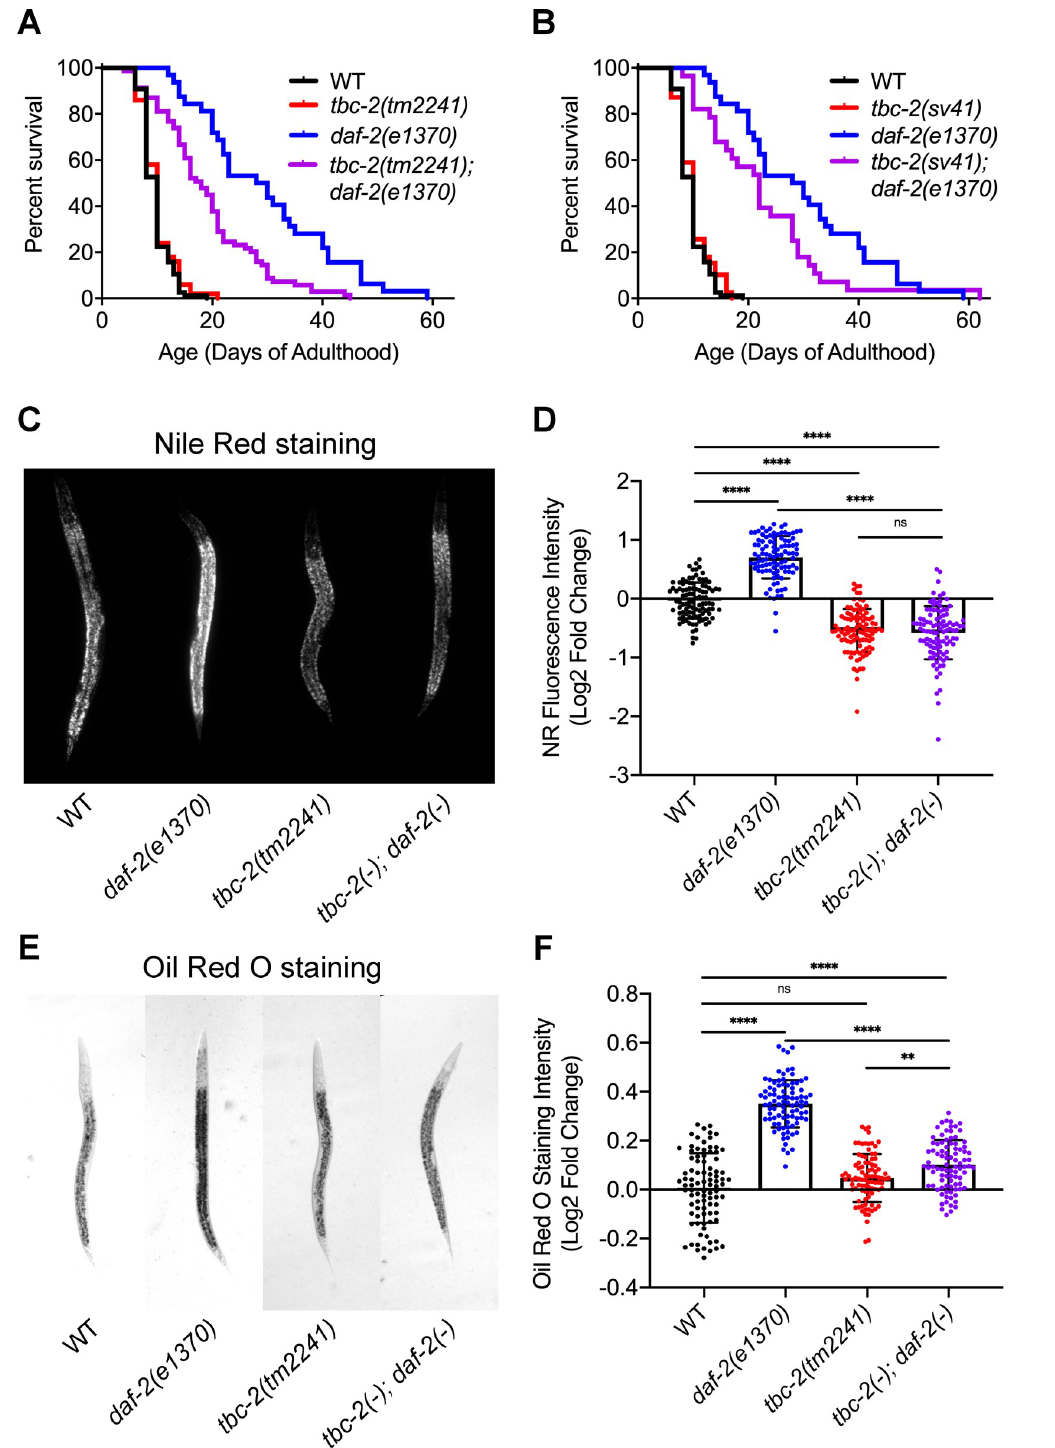
Fig 5. TBC-2 is required for full lifespan extension and increased fat storage resulting from decreased insulin/IGF signaling. (A,B) Percent survival curve of adult animals of wild-type and daf-2(e1370) with either tbc-2(tm2241) and tbc-2(tm2241); daf-2 (e1370) (A) or tbc-2(sv41) and tbc-2(sv41); daf-2(e1370) (B) genotypes. The survival of all strains are statistically different from daf- 2(e1370) animals as determined by a Mantel-Cox log-rank test: tbc-2(tm2241); daf-2(e1370) ( P < 0 . 001 )and tbc-2(sv41); daf-2 (e1370) ( P = 0 . 0314 ). Cumulative data from three independent replicates of 50 young adults for a total of 150. (C,E)